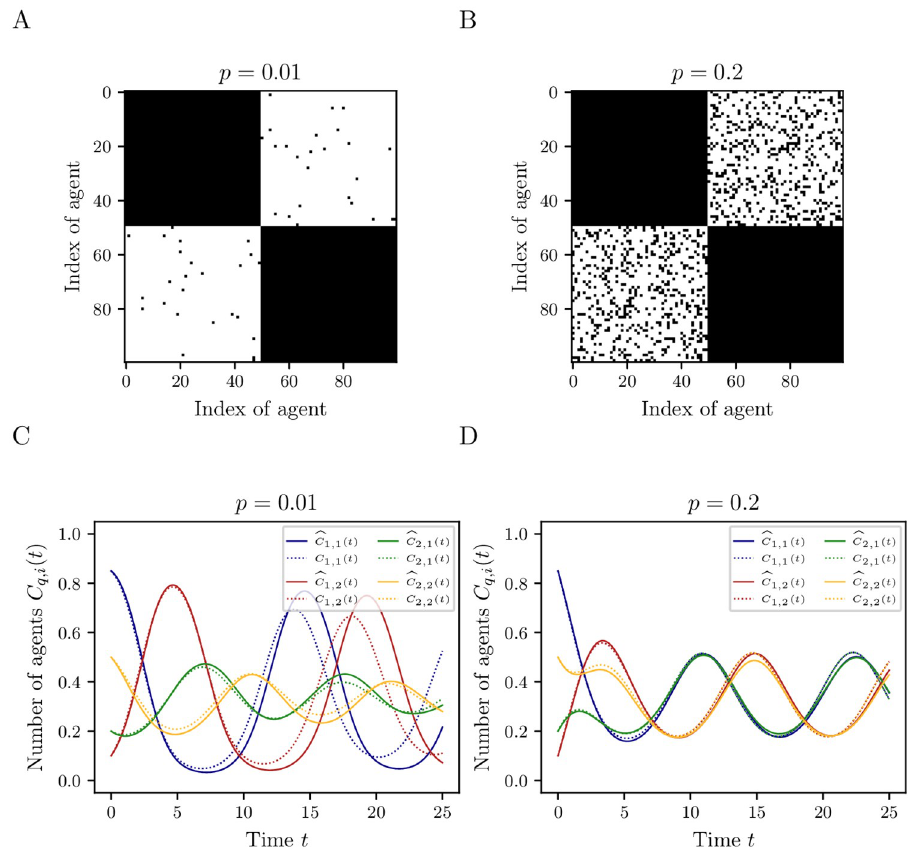
Fig 6. Prediction of extended voter model for clustered networks. (A) & (B) Adjacency matrices of the networks where black represents 1 (existing edge) and white 0 (no edge). (C) & (D) First-order moment of the data-driven coarse-grained model (solid) and the limit SDE (dotted) (14) for two clusters with N = 50 agents, γ 12 = γ 23 = γ 31 = 2, γ 13 = γ 21 = γ 32 = 1, g 0 ¼ 0 for all i , j = 1, ... , 3 and c (0) = [0.85, 0.1, 0.05, 0.2, 0.5, 0.3] > . The data-driven model is estimated ij using k = 1000 realizations of m = 1000 measurements for lag time τ =